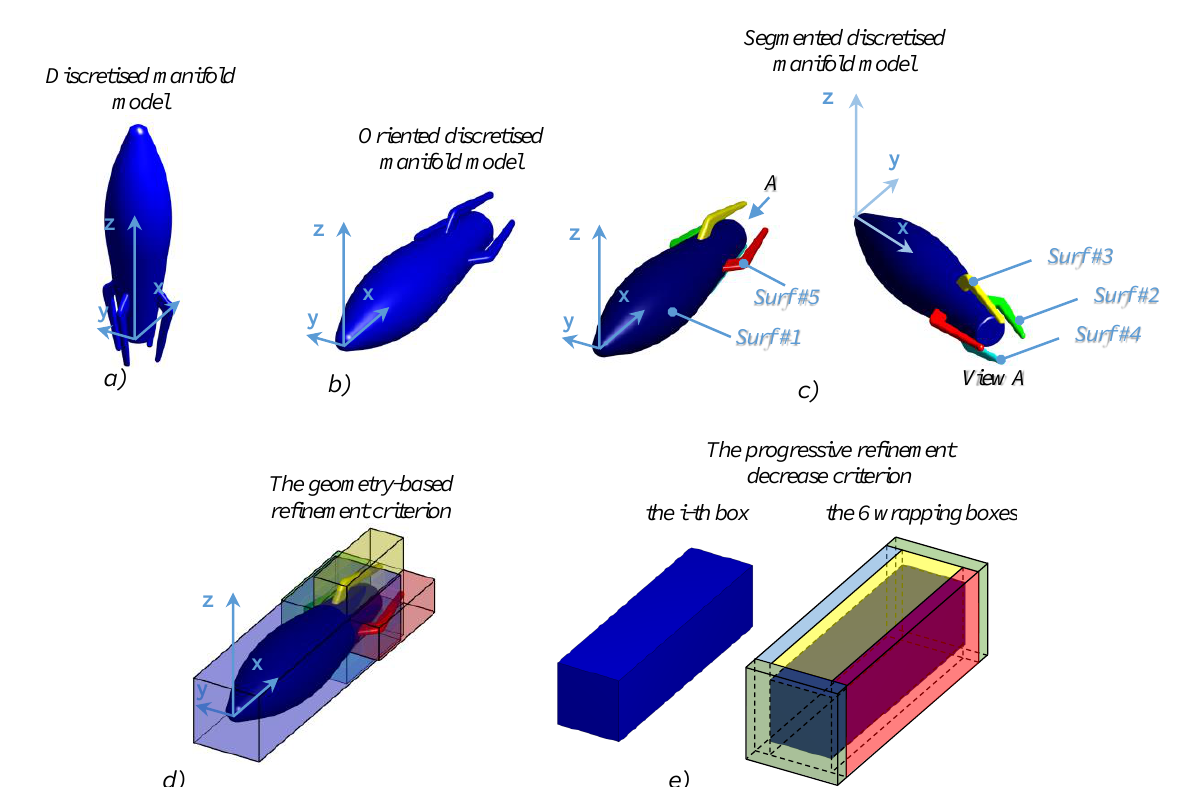
Figure 2. Key steps of the proposed grid generation method: ( a ) the imported discretised manifold model; ( b ) the oriented discretised manifold model; ( c ) the results of the discretised manifold model segmentation; ( d ) the boxes generated with the geometry-based refinement criterion; ( e ) the boxes generated with the progressive refinement decrease